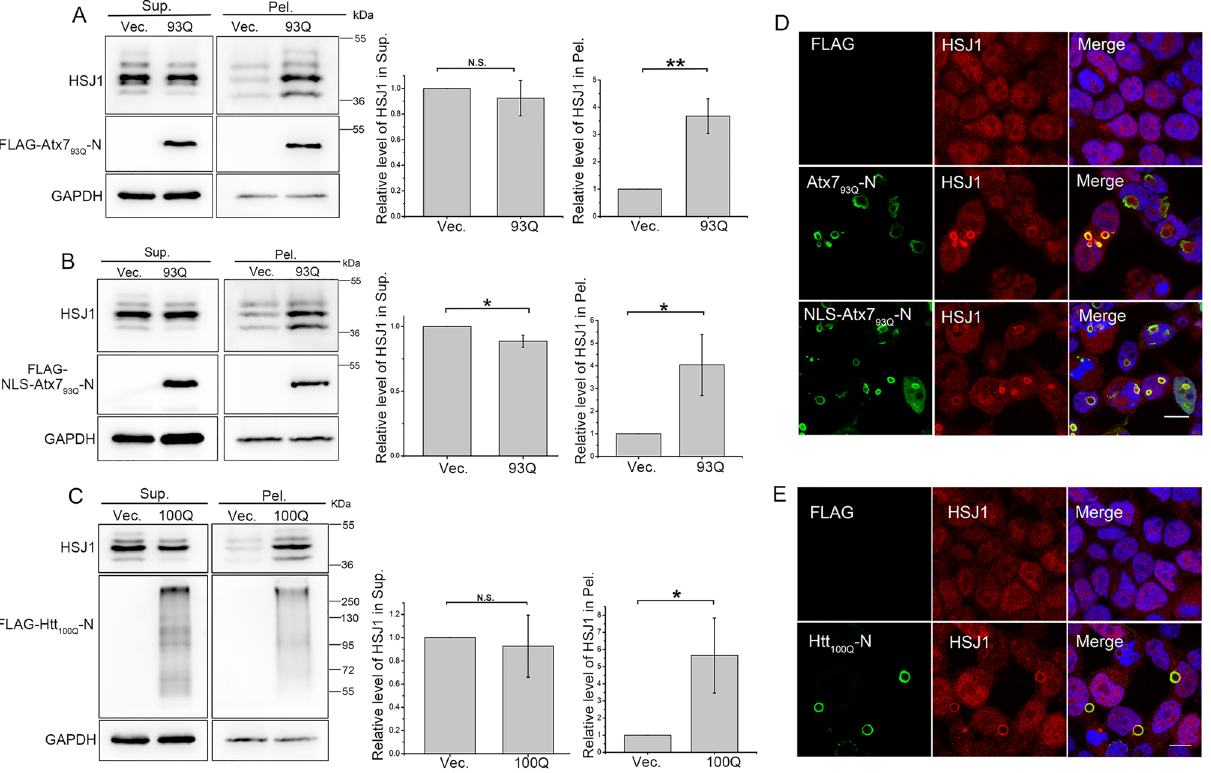
Figure 5. PQE Atx7 and Htt sequester endogenous HSJ1 into aggregates. ( A ) Sequestration of endogenous HSJ1 by Atx7 93Q -N172. ( B ) As in ( A ), by NLS-Atx7 93Q -N172. ( C ) As in ( A ), by Htt 100Q -N90. HEK 293T cells were transfected with each indicated plasmid and the lysates were subjected to supernatant/pellet fractionation and Western blotting. Indicated proteins were detected by using anti-FLAG, anti-HSJ1 and anti-GAPDH antibodies. The three main bands indicate different isoforms of endogenous HSJ1. Sup., supernatant; Pel., pellet. Data are shown as Means ± SEM (n = 3). * p < 0.05; ** p < 0.01; N.S., no significance. ( D ) Immunofluorescence imaging showing that Atx7 93Q -N172 sequesters endogenous HSJ1 into inclusions. ( E ) As in ( D ), Htt 100Q -N90. HEK 293T cells were transfected with indicated plasmids and then subjected to immunofluorescence imaging. PolyQ proteins were stained with anti-FLAG antibody (green), HSJ1 was stained with anti-HSJ1 antibody (red), and nuclei were stained with Hoechst (blue). Scale bar = 10